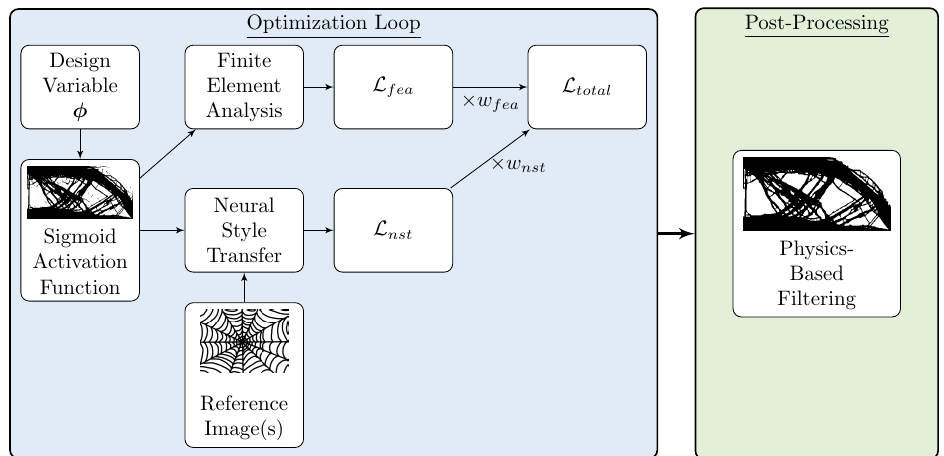
Figure 1. Op-Level Flowchart for each